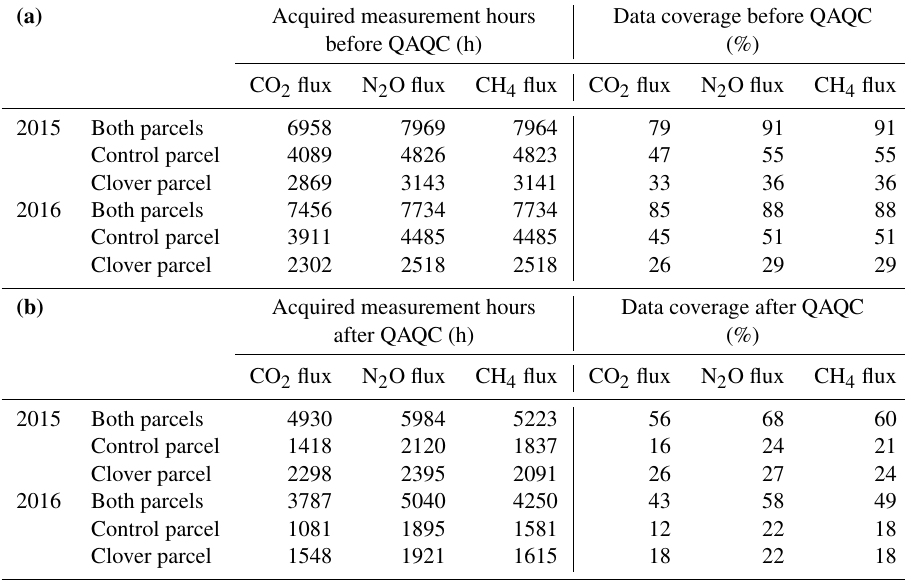
Table 3. Data availability of the GHG flux measurements over the 2-year experimental period (a) before quality assessment and quality control (QAQC) (flagged 0, 1, and 2; after Foken et al., 2004) and (b) after QAQC (acceptable quality flagged 0 and 1; after Foken et al., 2004). The reference for 100% is a year without data